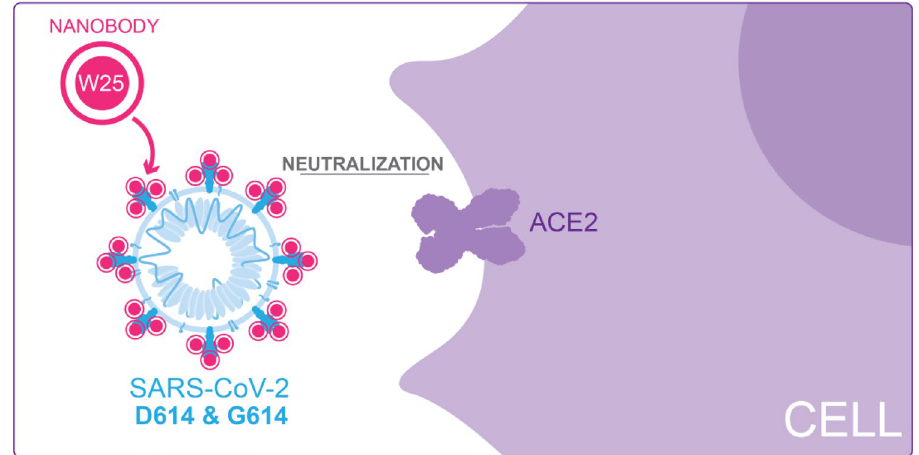
Figure 4. Diagram of W25 neutralization of SARS-CoV-2. Illustration by Felipe G. Serrano BSc., MSc Scientific